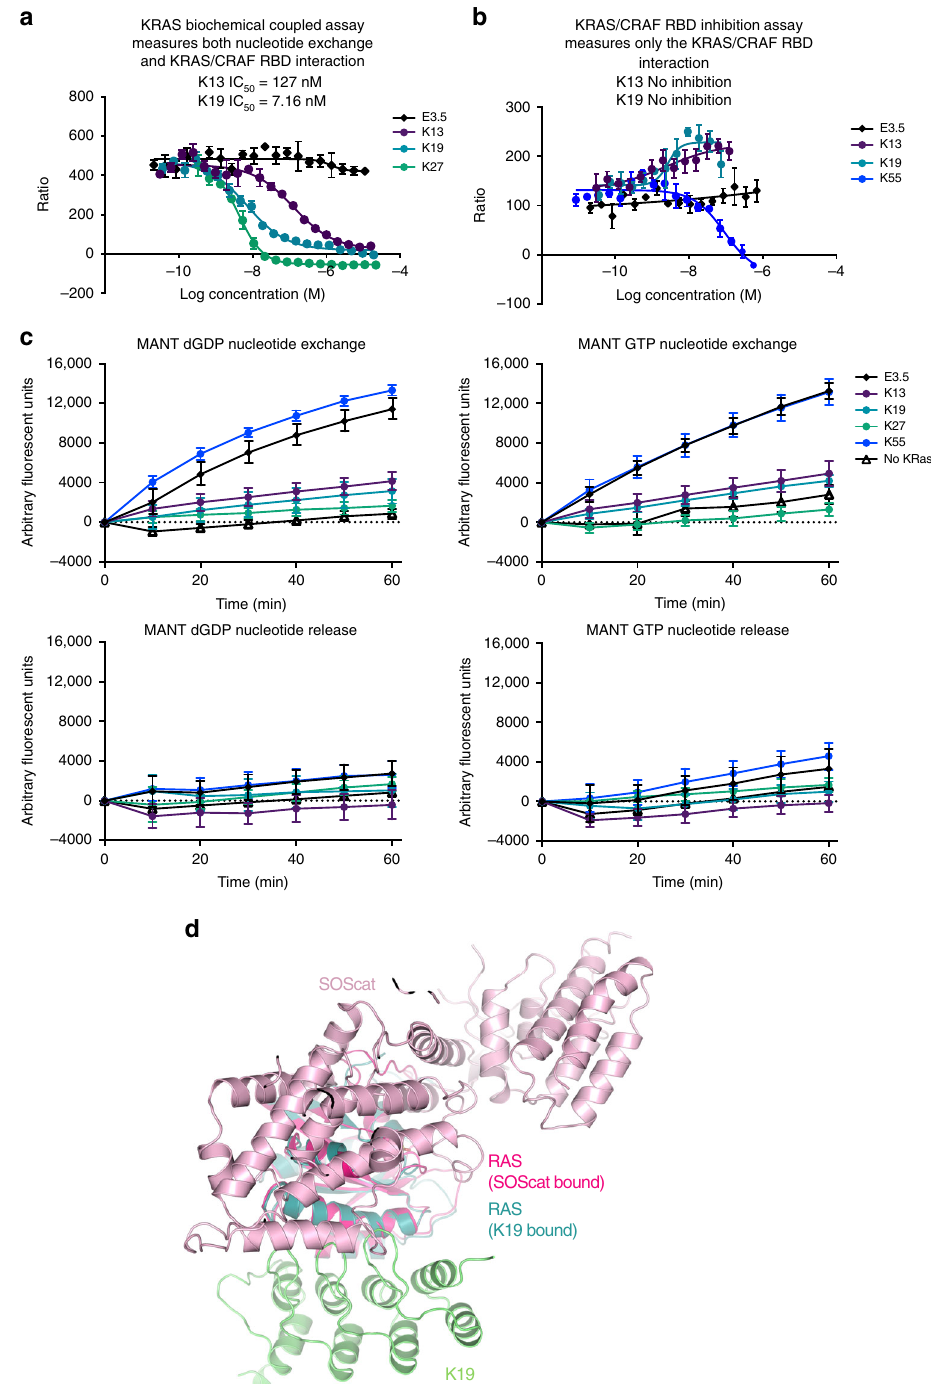
Fig. 6 K13 and K19 inhibit KRAS nucleotide exchange. a KRAS biochemical coupled assay for inhibition of nucleotide exchange or KRAS/CRAF RBD interaction by DARPins K13, K19 or negative control DARPin E3.5. KRAS G12V loaded with GDP was incubated for 15 min with a dilution series of DARPins K13, K19, K27 or E3.5. SOS and GTP γ S were added to allow nucleotide exchange, followed by CRAF RBD. The KRAS G12V -GTP γ S/CRAF RBD complex was quantitated by the FRET signal. b KRAS/CRAF RBD inhibition assay testing DARPins K13, K19, K55 (a known KRAS/CRAF RBD inhibitor) and E3.5. The FRET signal was measured for the interaction between CRAF RBD and KRAS G12V loaded with GTP γ S and inhibition of the signal monitored at varying concentrations of DARPins K13, K19, K55 and E3.5. Error bars represent the mean ± SD ( n = 3). c MANT dGDP and MANT GTP nucleotide exchange and release assays. SOS-mediated exchange of MANT-labelled dGDP or GTP on KRAS G12V was studied over time upon addition of 10 μ M concentrations of DARPins. Included controls were previously published RAS-binding DARPins K55 (non-inhibitor of nucleotide exchange) and K27 (inhibitor of nucleotide exchange). For release assays, DARPins were added after equilibration of MANT nucleotides. In these assays, the binding of MANT-labelled nucleotides to KRAS G12V results in an increase in fl uorescence, detected by measuring light emission at a wavelength of 450 nm. Error bars represent the mean ± SD ( n = 8). d Superimposition of K19/KRAS G12V -GDP (PDB 6H47) and SOScat structures (PDB